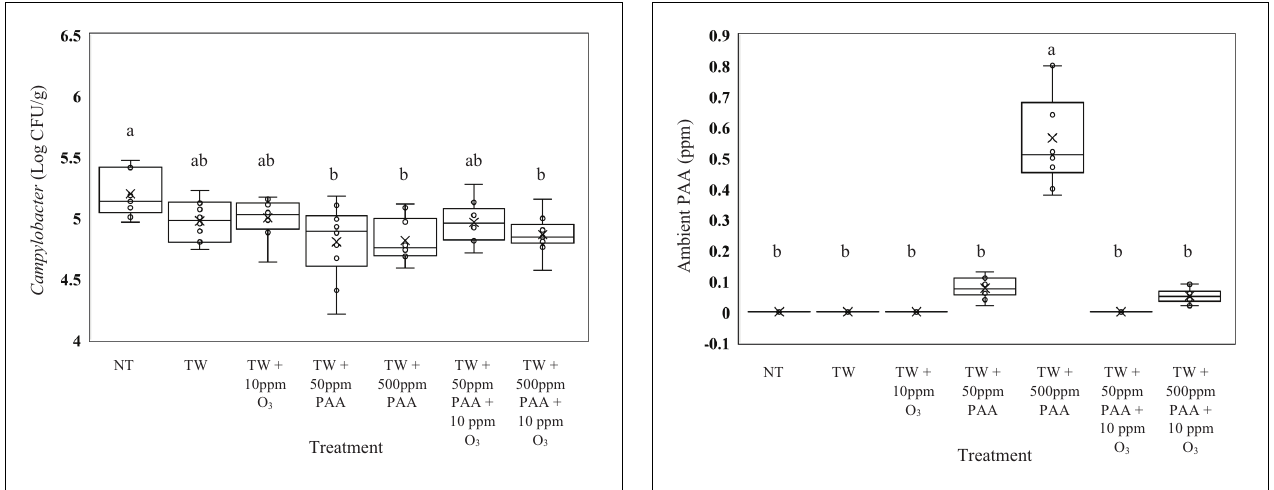
FIGURE 4 | The effect of applying PAA alone and in combination with aqueous ozone at 10 ppm on whole hen carcasses on the mean ppm of the surrounding ambient PAA 1 , 2 . Carcasses were inoculated with Salmonella Typhimurium UK-1, E. coli J53, and C. jejuni . Birds were then placed in a modified spray cabinet to be treated for 5 s (4 × ) via a low pressurized spray. While the treatments were being applied, a ChemDaq SafeCide ambient PAA monitor and sensor, located outside the modified spray cabinet, was utilized to determine ppm of ambient PAA. 1 N = 70, n = 10, P < 0.0001. 2 Means with different superscripts are considered significantly different (a,b).